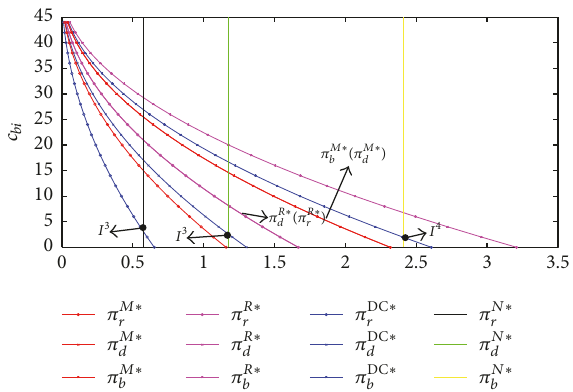
Figure 5: Effects of 𝑐 𝑏𝑖 on the benefits of supply chain